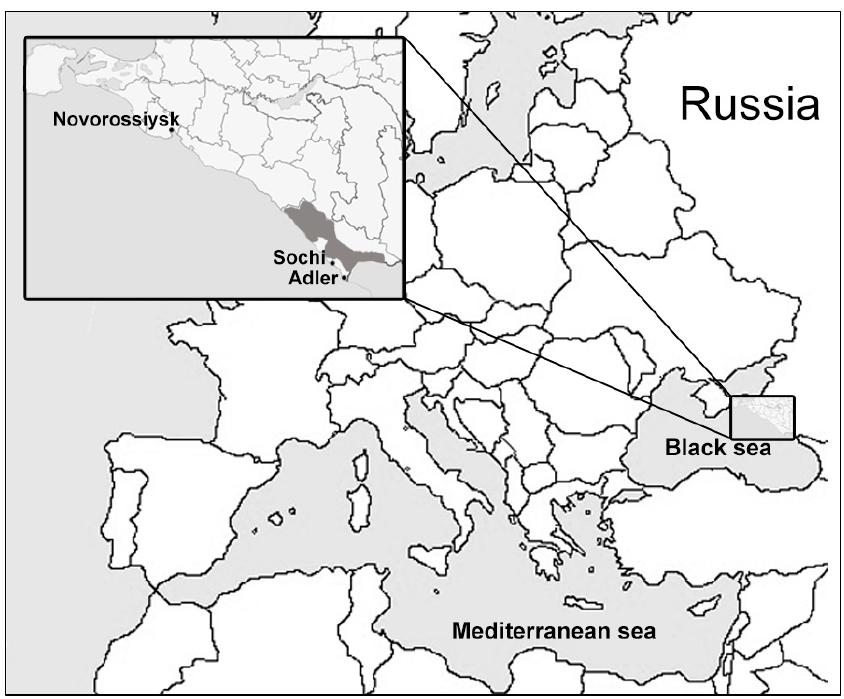
Figure 1. Map of the region where bat samples were collected. The location of Sochi National Park and the surrounding area is shown in gray.